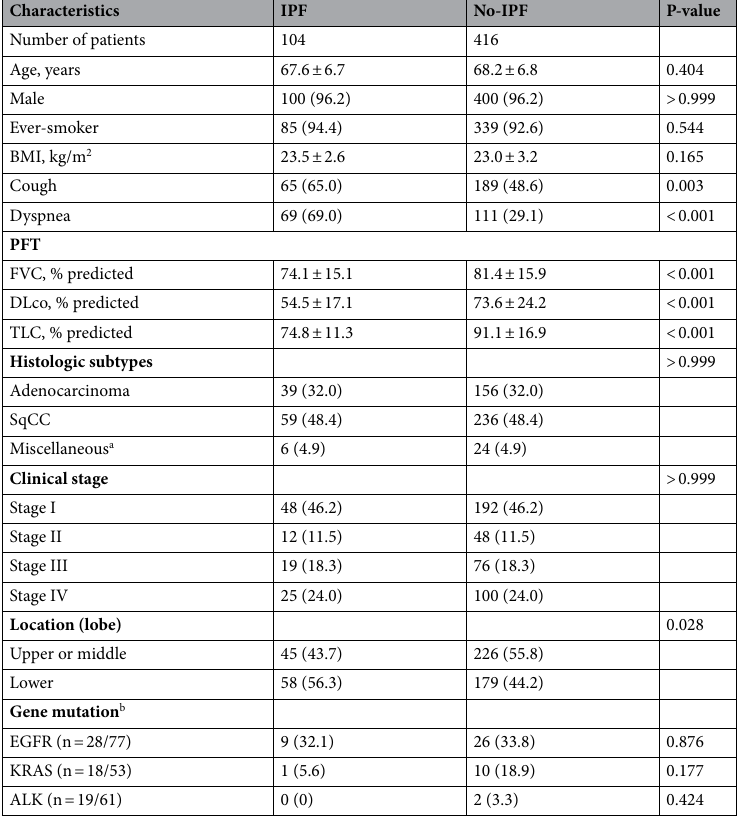
Table 1. Comparison of the baseline characteristics of NSCLC between the IPF and no-IPF groups. Data are presented as mean ± SD or number (%), unless otherwise indicated. NSCLC non-small cell lung cancer,